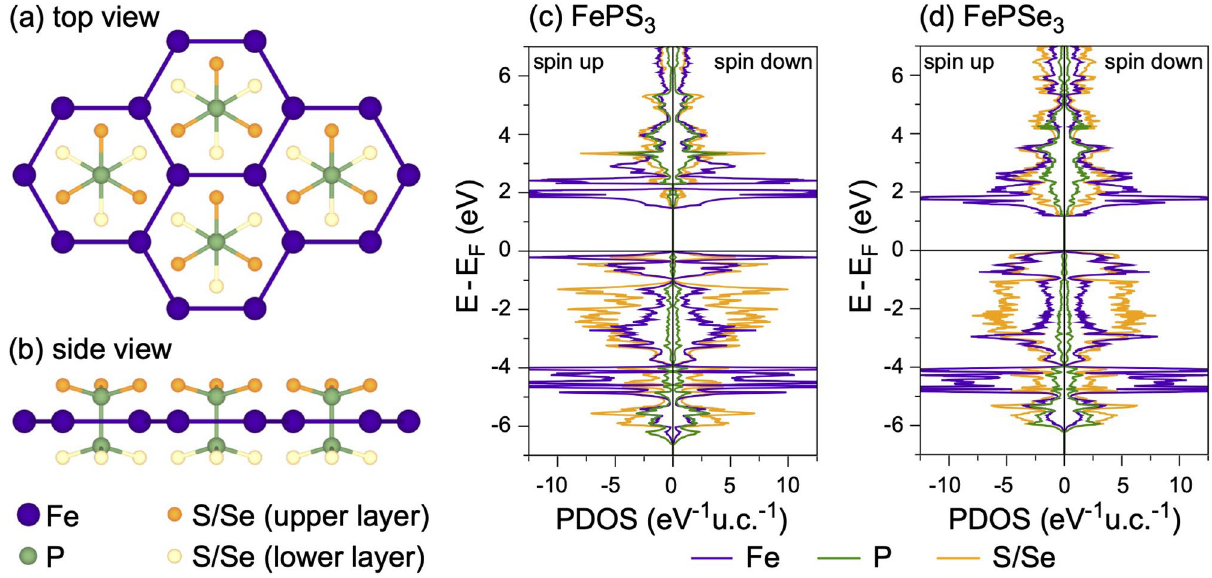
Figure 1. Top ( a ) and side ( b ) views of the crystallographic structure of the FePX 3 (X: S or Se) single layer. Atom-projected partial DOS for bulk FePS 3 ( c ) and FePSe 3 ( d ) in the AFM ground state. Images are created using CrystalMaker X (Version: 10.7.0), http:// www. cryst almak er. com and Igor Pro (Version 9), https:// www. wavem etrics.